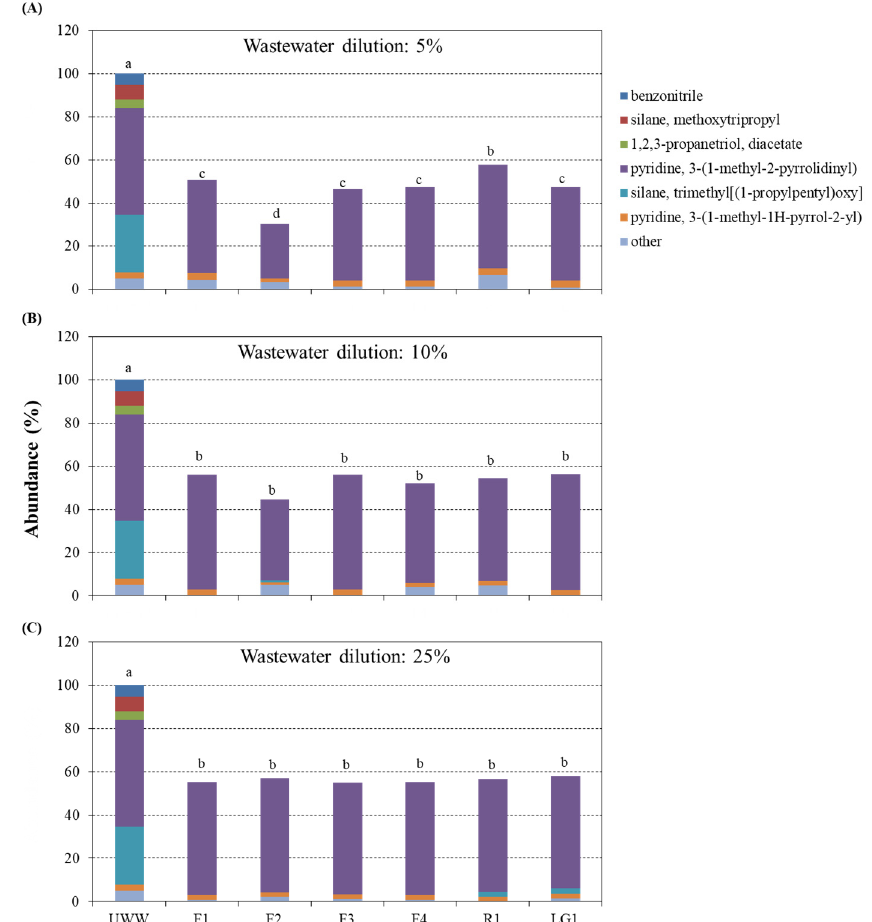
Figure 3. Chemical composition of the wastewater from the cigarette butts (CB) cleaning process subjected to microalgal-based remediation. Six microalgal strains (F1, F2, F3, F4, R1 and LG1) were exposed to different CB wastewater dilutions: ( A ) 5, ( B ) 10 and ( C ) 25%. The remediation capacity of each strain was evaluated after 7 days. UWW represents the respective CB wastewater dilution without microalgae under the same growth conditions for 7 days, for more details see Material and Methods. The total abundance of chemical compounds in UWW was expressed as 100%. The abundance of remaining compounds in wastewater after microalgal-based remediation was obtained by its comparison with UWW. Different letters represent significant differences ( p < 0.05) between the total abundance of chemical compounds in UWW and microalgal treated wastewater. Data are the means of 4 different replicates.